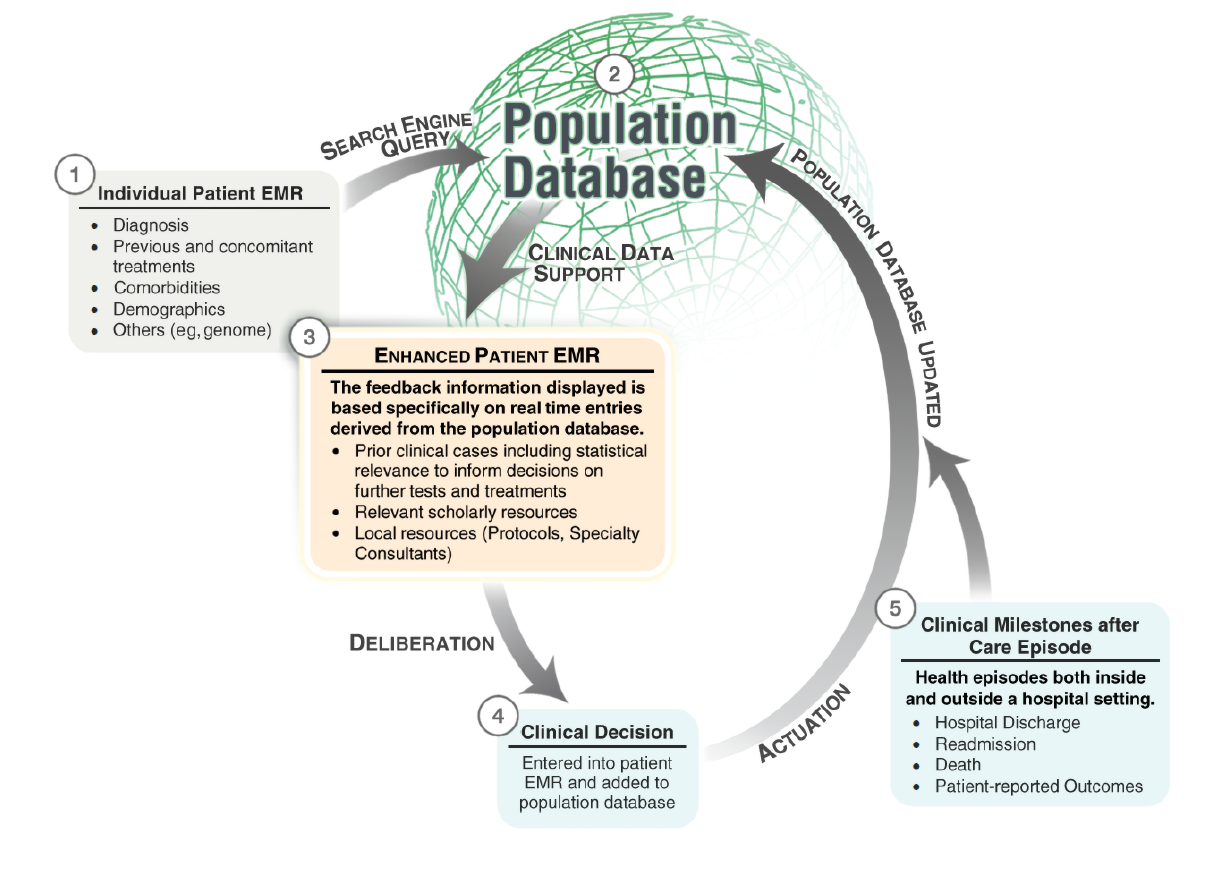
Figure 1. Dynamic clinical data mining. Figure courtesy of Kai-ou Tang and Edward Moseley. EMR=electronic medical